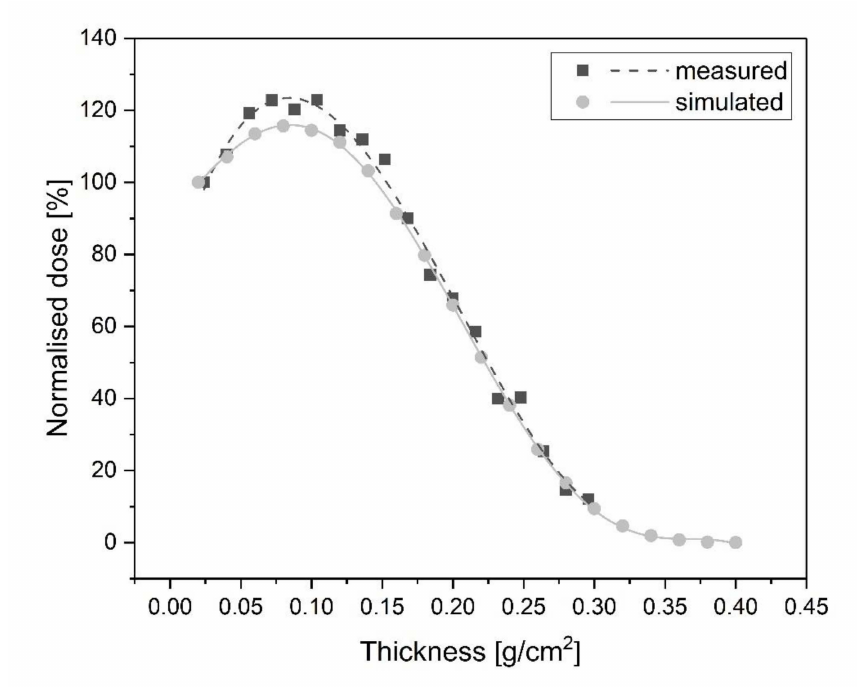
Figure 3. Simulated and experimentally determined depth dose curve of electron beam for irradiation conditions with ILU 6 accelerator.